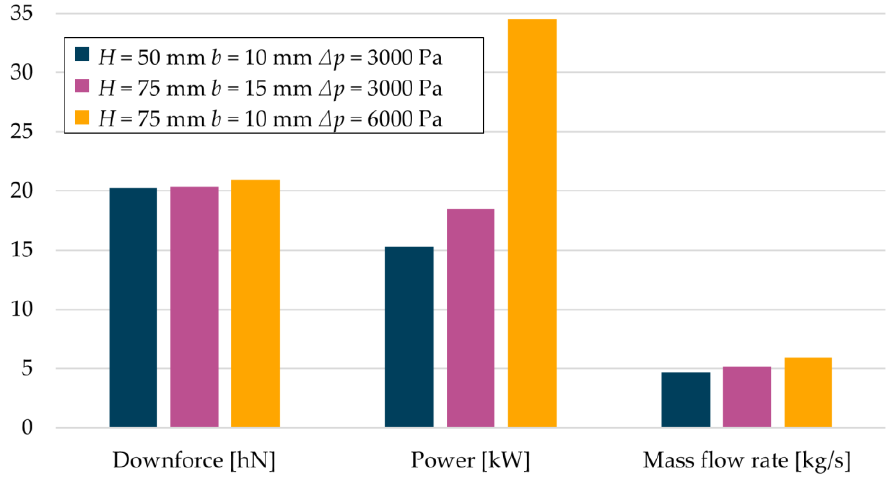
Figure 15. Conditions needed to change curtain height from 50 mm to 75 mm for the same aerody- namic downforce generated.